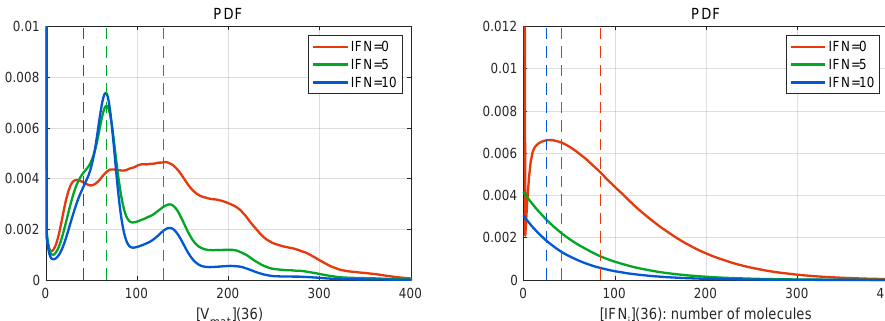
Figure 8. Histograms of mature virions ( left ) and intercellular IFN ( right ) at time t = 36 h for MOI = 6 and different values of [ IFN e ]( 0 ) . The line colours are explained in the legend. The dashed vertical lines indicate the mean values for the corresponding initial extracellular IFN. The histograms are normalised by the number of realisations to approximate the probability distribution function (PDF). They are slightly smoothed by using the Gaussian filter. Both distributions shown are far from the normal distribution.